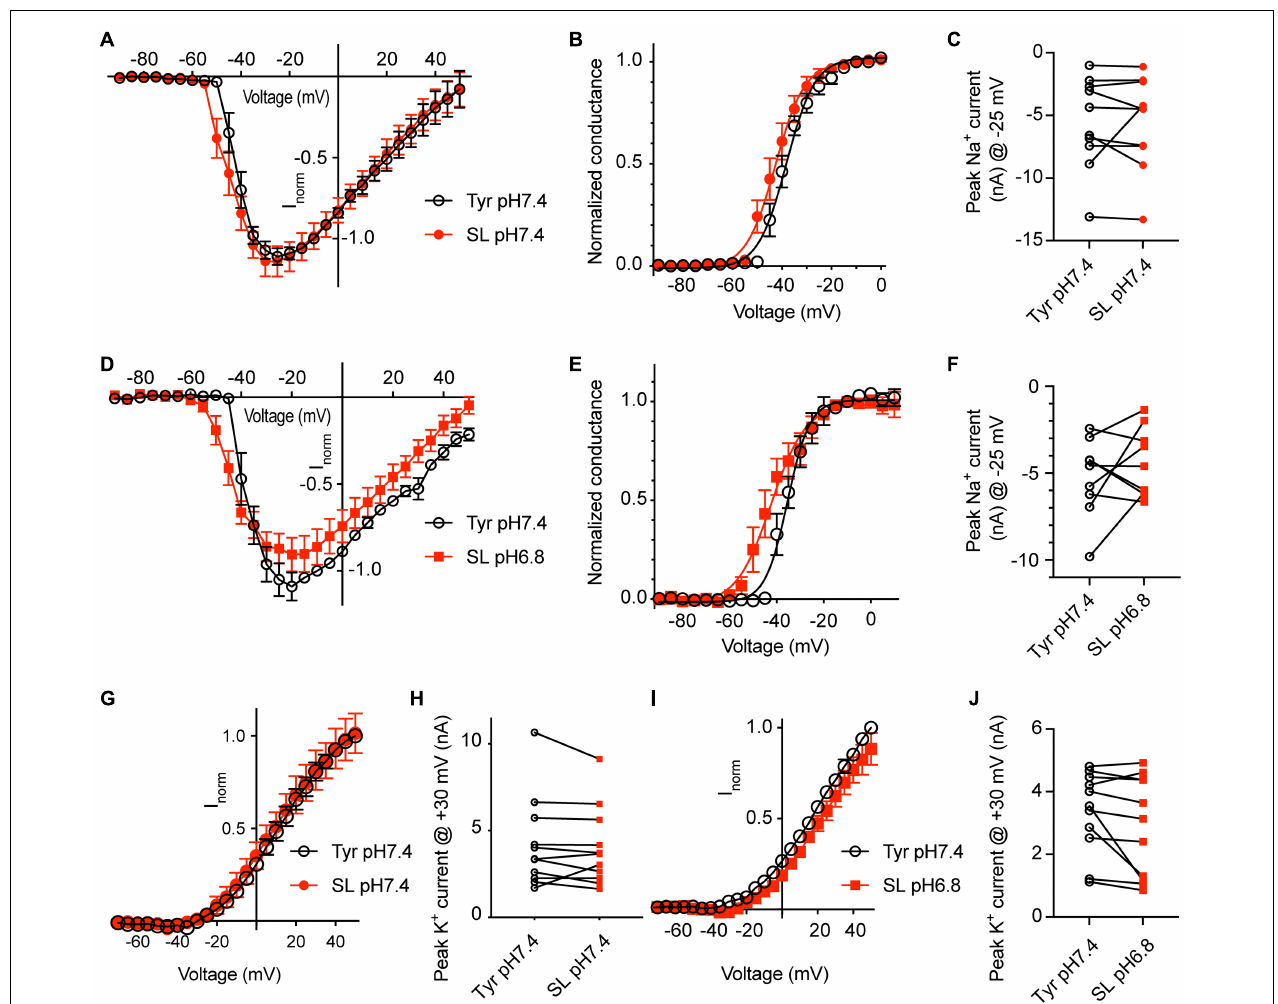
FIGURE 7 | Solutions mimicking seizure-like conditions change the voltage dependence of voltage-gated Na + channels. Experiments were done in whole-cell voltage-clamp on cortical neurons from WT mice. The response to two different solutions was directly compared in the same cell. (A–C) Between the two conditions, only the Ca 2 + and K + concentration, but not the pH was changed. (A) Na V I-V curve in Tyr-pH7.4 or SL-pH7.4 solution. Current amplitudes were normalized in each cell to the amplitude measured in the Tyr solution at –10 mV, n = 10. (B) Na V conductance-voltage curve in Tyr-pH7.4 or SL-pH7.4 solution. The conductance was normalized for each condition to the conductance determined at –10 mV. The V 1 / 2 values were –39.0 ± 1.6 mV (Tyr) and –42.3 ± 2.1 mV (SL, p = 0.041, n = 10, paired t -test). (C) Na V peak current amplitudes at –25 mV, measured in Tyr and SL solution at pH7.4 ( n = 10). (D–F) Comparison of Na V properties between Tyr-pH7.4 and SL-pH6.8 conditions in paired experiments. (D) Na V I-V curve in Tyr-pH7.4 or SL-pH6.8 solution from paired experiments. Current amplitudes were normalized in each cell to the amplitude measured in the Tyr solution at –10 mV, n = 10. (E) Na V conductance-voltage curve in Tyr-pH7.4 or SL-pH6.8 solution. The conductance was normalized for each condition to the conductance determined at –10 mV. The V 1 / 2 values were –34.2 ± 2.1 mV (Tyr-pH7.4) and –41.0 ± 3.0 mV (SL-pH6.8). (F) Na V peak current amplitudes at –25 mV, measured in Tyr-pH7.4 and SL-pH6.8 solution ( n = 10). (G) I–V curve of K + currents, measured in Tyr-pH7.4 and SL-pH7.4 solution, n = 11. (H) K + peak amplitude, measured at + 30 mV, in Tyr-pH7.4 and SL-pH7.4 solution, n = 11. (I) I–V curve of K + currents, measured in Tyr-pH7.4 and SL-pH6.8 solution, n = 11. (J) K + peak amplitude at + 30 mV, measured in Tyr-pH7.4 and SL-pH6.8 solution, n = 11. The current amplitudes compared in (C,F,H,J) were not different between the two conditions tested. (G,I) In each cell, the current amplitudes measured were normalized to the amplitude measured in the Tyr-pH7.4 condition at + 50